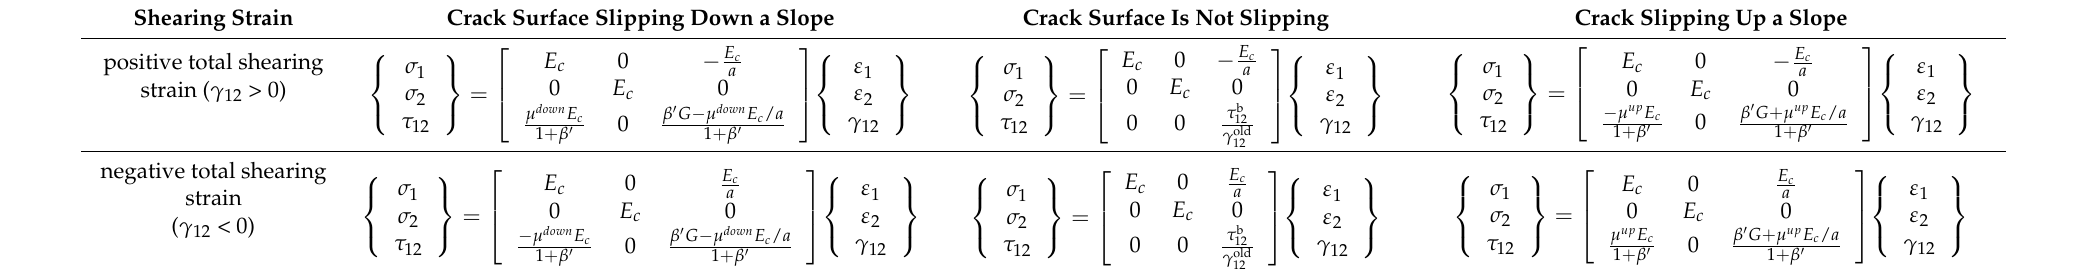
Table 3. Secant stiffness matrices at crack direction 1 (active).